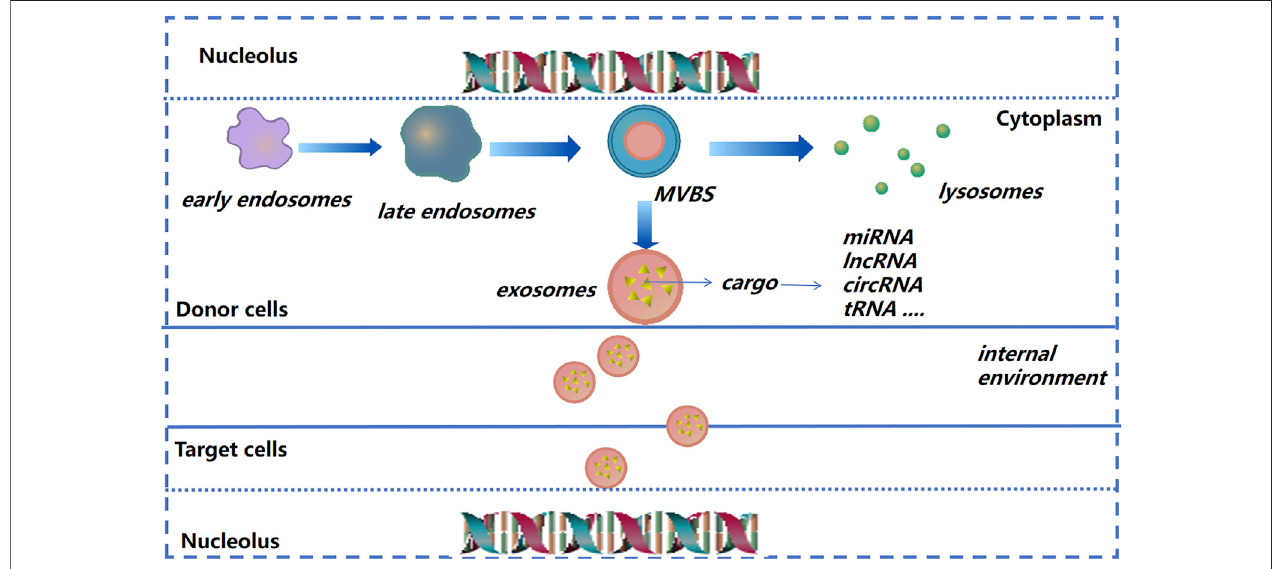
FIGURE2| Exosomeformationandcargorelease(schematic).Astheendocardiumoftheearlyendosomeformsavesicleintotheinnerbud,anexosomebeginsto form and then transform into multivesicular bodies. The latter can release vesicles after fusion with the plasma membrane, and are then known as “ exosomes. ”